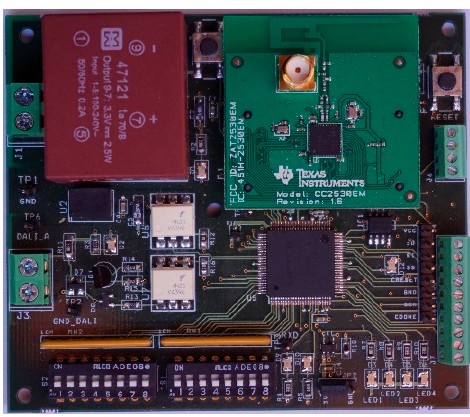
Figure 17. Wireless sensor node: UCODALIB.